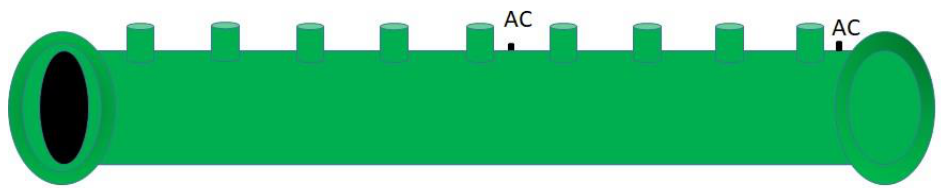
Figure 10. The wires are helically wrapped over a pipe of this type to result in the ability to measure acoustically the health of the system [87].